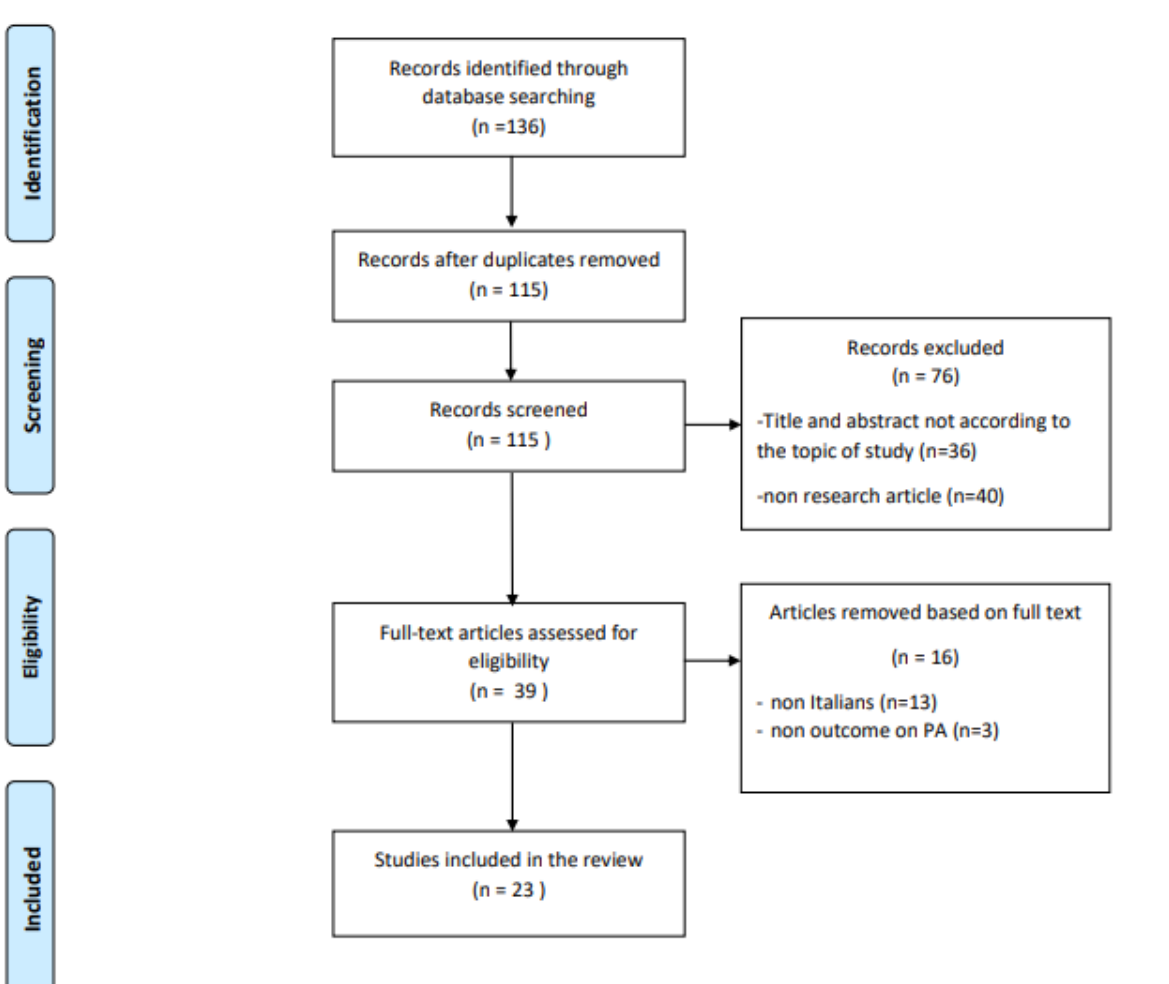
Figure 1. Flow diagram of the literature search strategy and review process, following PRISMA rules [9].